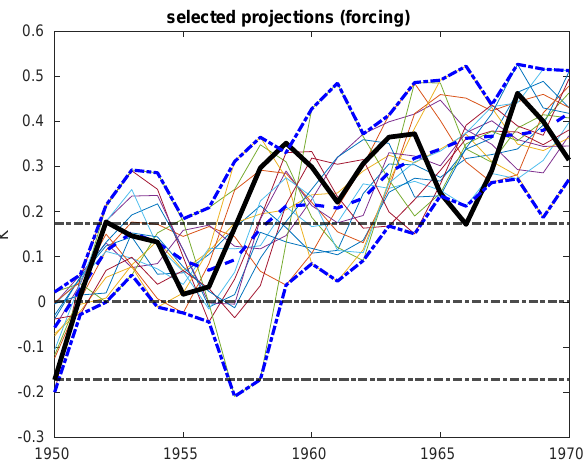
Figure 7. As in Figure 5c, but where only a selected subset of projection members have been included in the projection ensemble. The selected subset are within ± 0.05 K of the observation member at the second time step and have the same sign of change from the first to second time